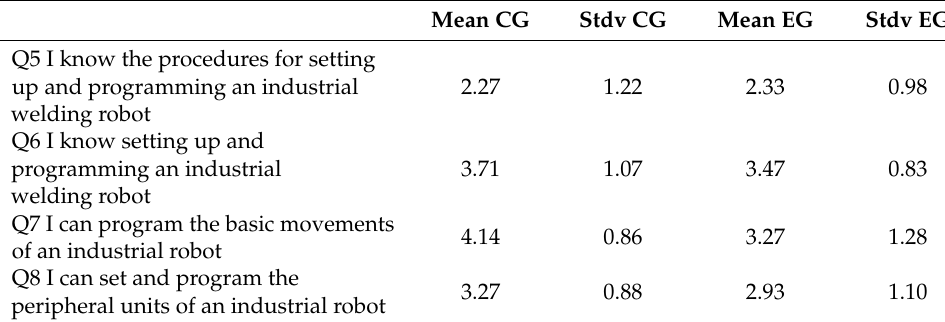
Table 2. Students pre-knowledge evaluation results.